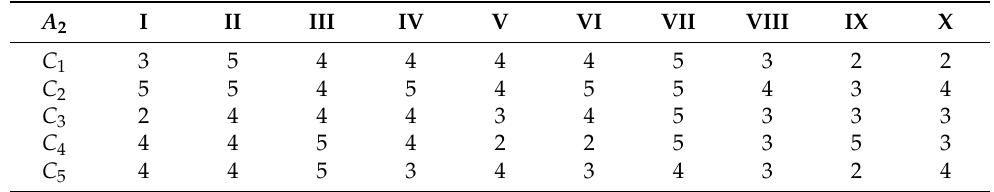
Table 3. Ratings of alternative A 2 in relation to the evaluation criteria obtained from 10